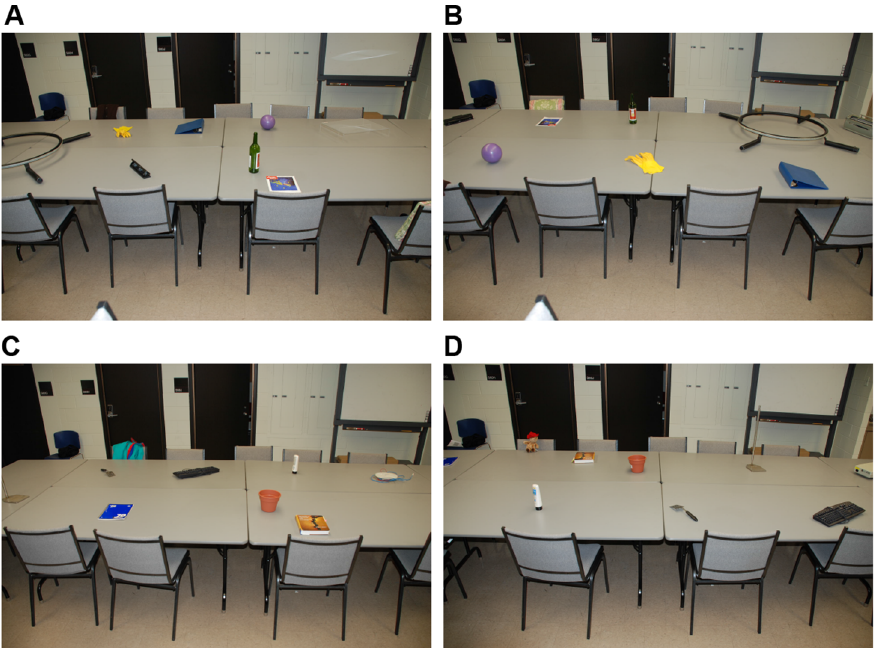
Figure 4. Example room photos for counterbalanced object set and map. (A) Set A–map 1; (B) Set A–map 2; (C) Set B–map 1; (D) Set B–map 2.